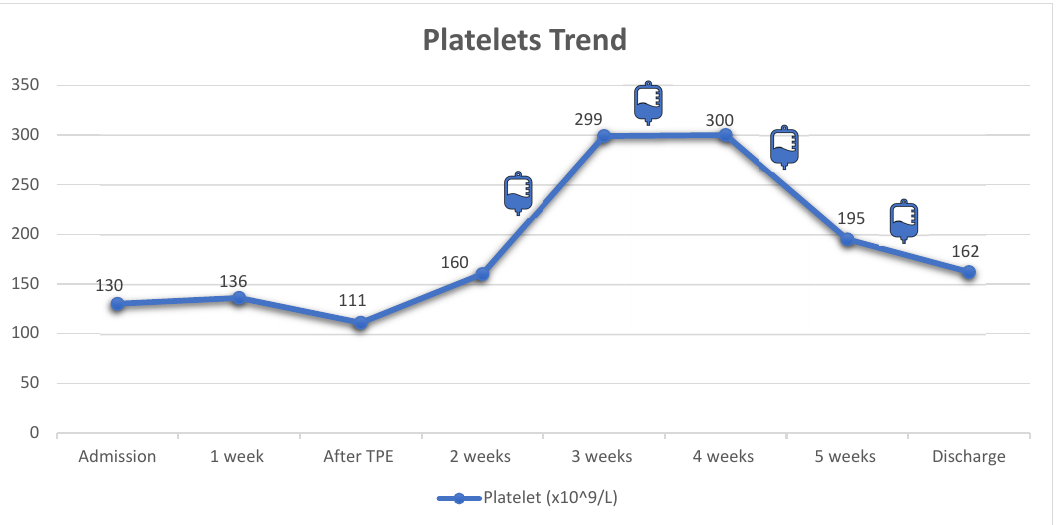
Figure 1. Trend of platelets count during hospital course. The infusion bag icons correlate with the time of each rituximab dose. Corticosteroids were not shown in the graph because the patient received daily dose since admission (IV methylprednisolone in the first 4 days and then switched to prednisolone tablets). TPE: therapeutic plasma exchange.